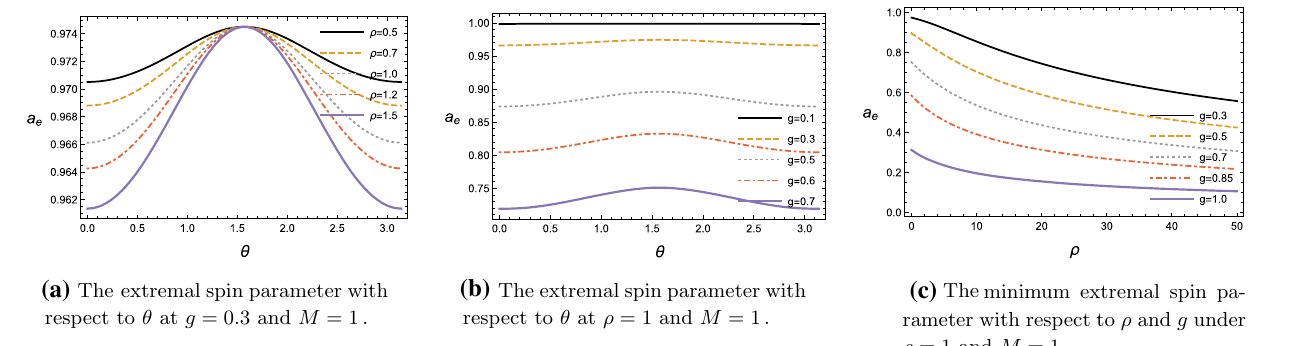
outer horizon at g = 0 . 3, M = 1, and a = 0 . 68. Fig. 1 The outer horizon and its surface for a positive ρ